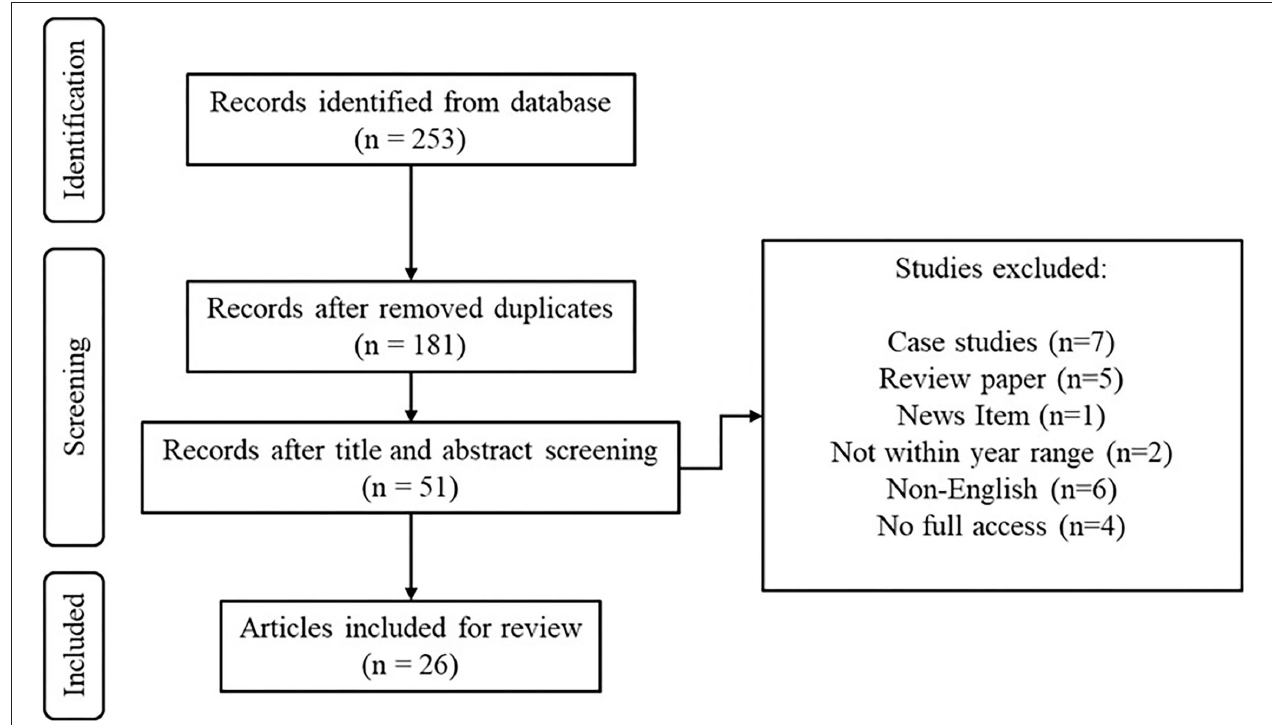
FIGURE 1 | PRISMA diagram for screening of articles from databases.